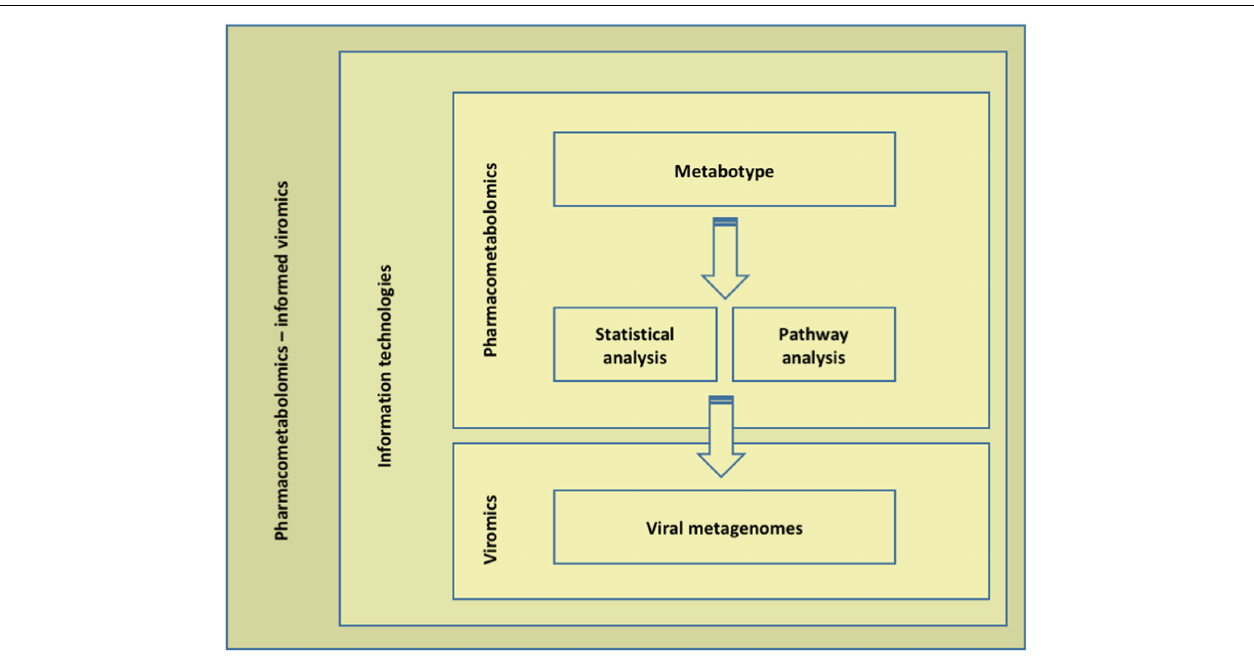
FIGURE 2 | A pharmacometabolomics-informed viromics workflow – the overall multilayered strategy. Instead of any single omics approach, we propose an integrated (transomic) analysis. In this context, we have two layers of systems-scale molecular measurements; the pharmacometabolome (layer 1) and the virome (layer 2). Layers 1 and 2 are coupled to information